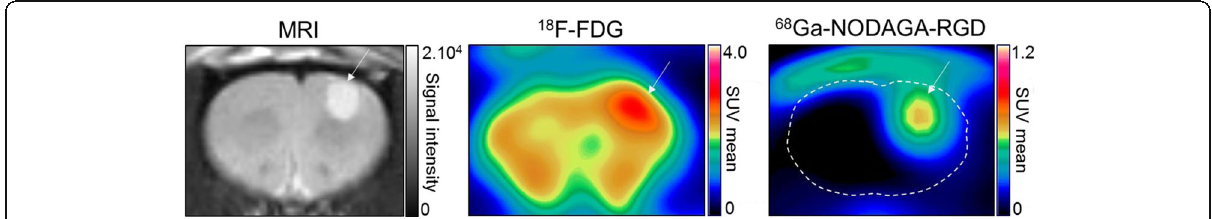
Fig. 5 Example of magnetic resonance images and PET images obtained with 18 F-FDG and with 68 Ga-NODAGA-RGD in a rat brain with an engrafted glioblastoma tumor (white